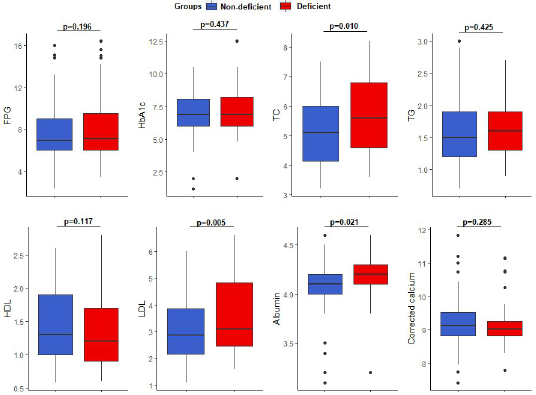
Fig 3. Comparison of select biochemical parameters based on vitamin B 12